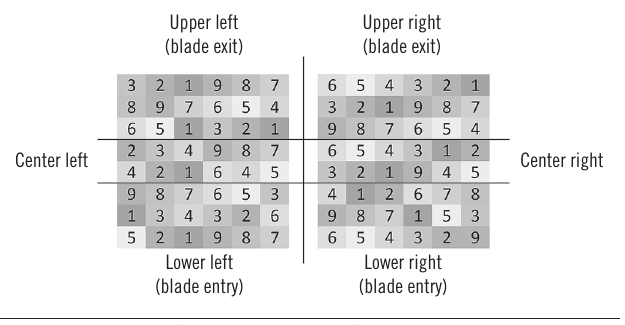
figurE 1 − Example of the experimental design of the recipient blocks The numbers represent the location of each tissue distributed throughout the block: 1) skin; 2) heart; 3) bowel; 4) lung; 5) liver; 6) spleen; 7) stomach; 8) kidney; 9)